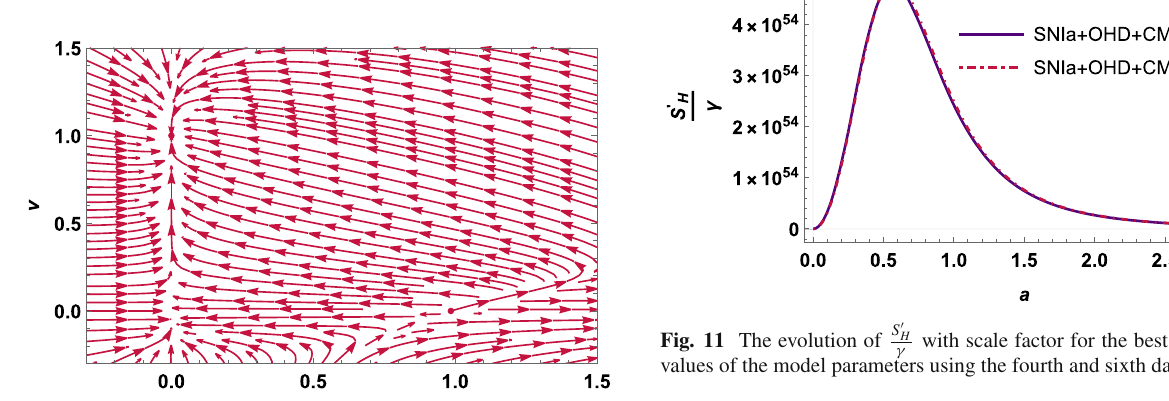
Fig. 8 The evolution of the phase space trajectories in the u − v plane for the best estimated model parameters using SNIa + OHD + CMB dataset